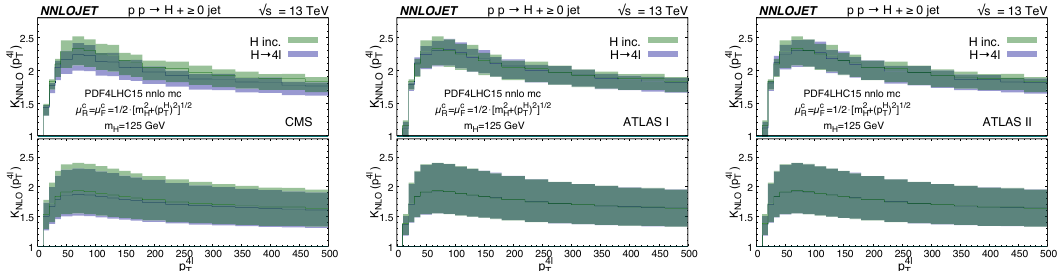
Figure 3. Transverse momentum distributions of the inclusive Higgs boson or four-lepton system from Higgs boson decay for CMS (left), ATLAS I (centre) and ATLAS II (right) cuts normalised by the corresponding LO